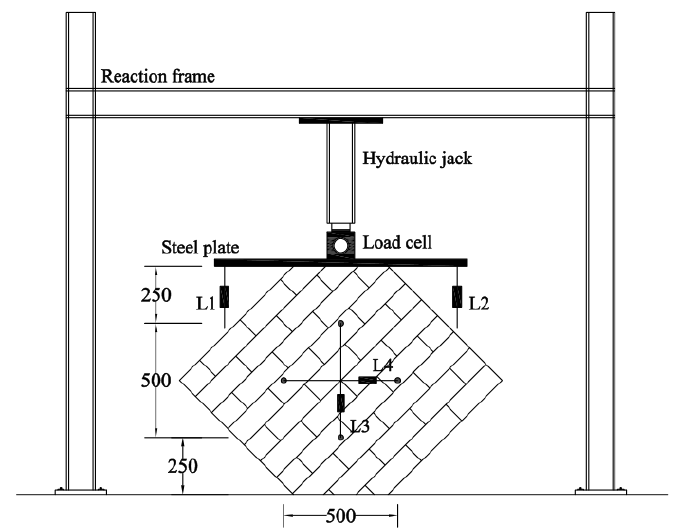
Figure 11. A pre-calibrated load cell of capacity 1000 kN was placed under the piston of the hydraulic jack to record the load. A steel plate 20 mm in thickness was placed at the top of the CCIHBM wall to safeguard the uniform application of the load. A total of four linear variable differential transducers (LVDT) were installed at different locations to measure the deformation of the CCIHBM walls under the applied load. The details of loading setup and installation of LVDTs are shown in Figures 11 and 12. Additionally, during the test, the appearance and propagation of the cracks was carefully marked and captured by using digital cameras.